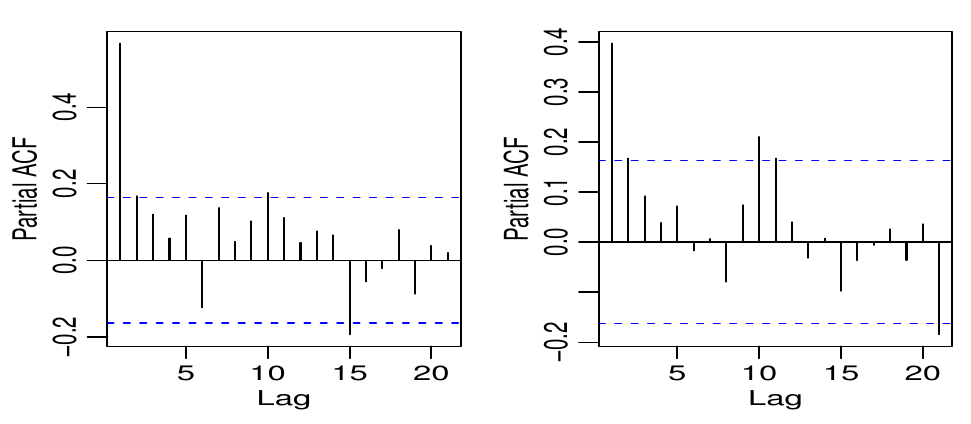
Figure 3. The PACF plot of CDRUGS and CSHOTS